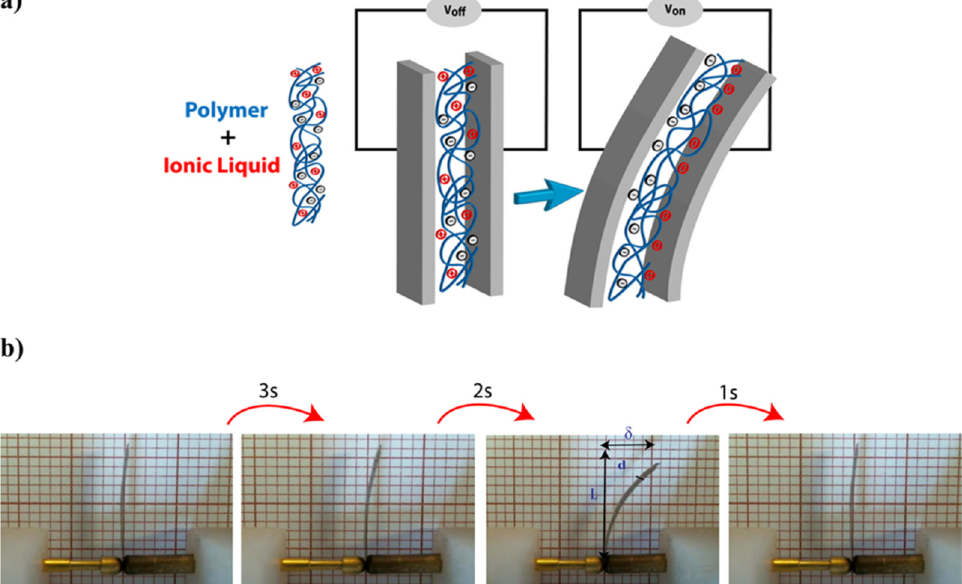
Figure 11. Electromechanical displacement illustration due to ion migration ( a ), and bending motion profile as a function of time for PVDF/[PMIm][TFSI] composite at 5V and 100 mHz ( b ) [9]. Reprinted with permission of the American Chemical Society.